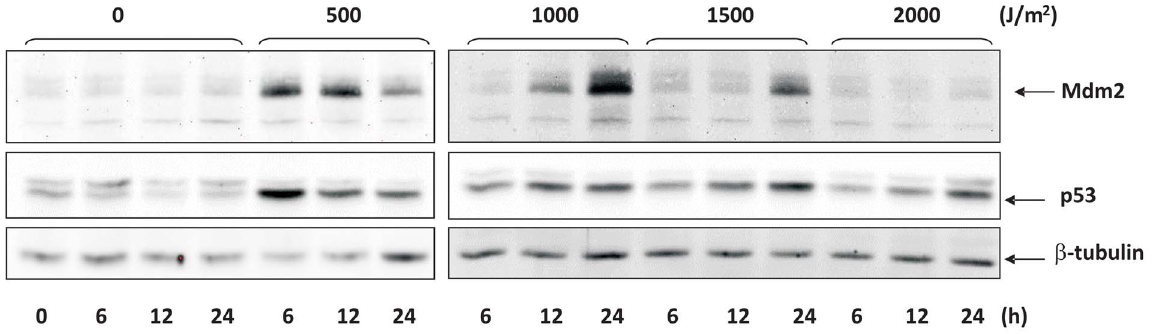
Figure 5. Kinetics of protein levels of Mdm2 and p53 in FHN fibroblasts irradiated with increasing doses of UVB (as indicated). Beta- tubulin was used as loading control.